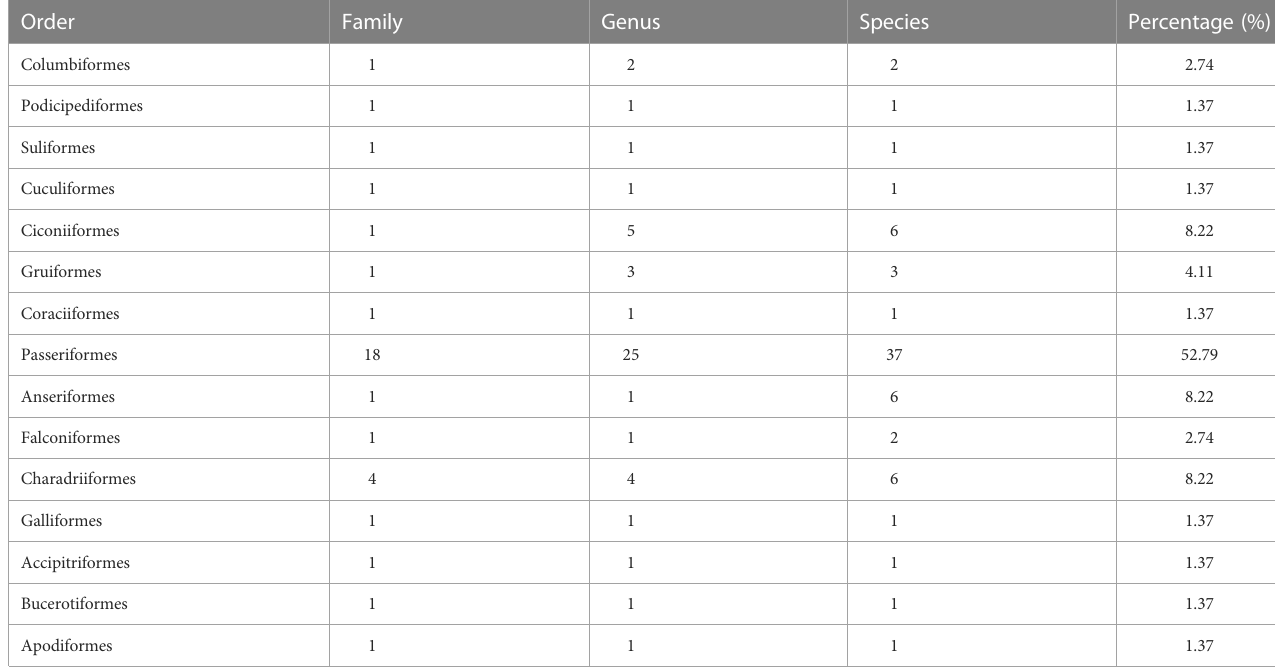
TABLE 2 Composition of different bird taxa in the Yingwuzhou